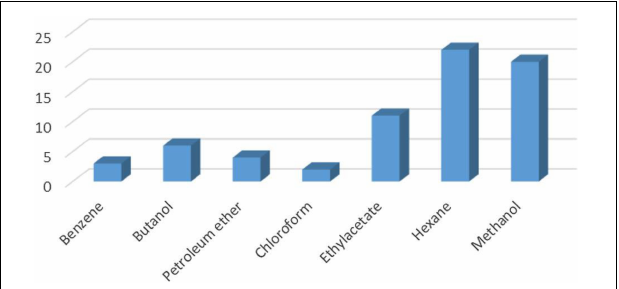
FIGURE 10 | Antibacterial activities of isolates BAMui, BAMli, BAMoii, BAMyi, BAMhi, and BAMpii against B. cereus and E. faecalis.